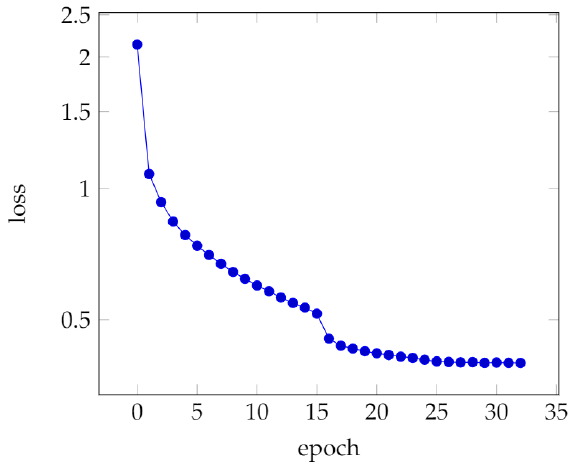
Figure 5. The example loss plot over training epochs of the proposed method with the log GSD scale dataset 1.